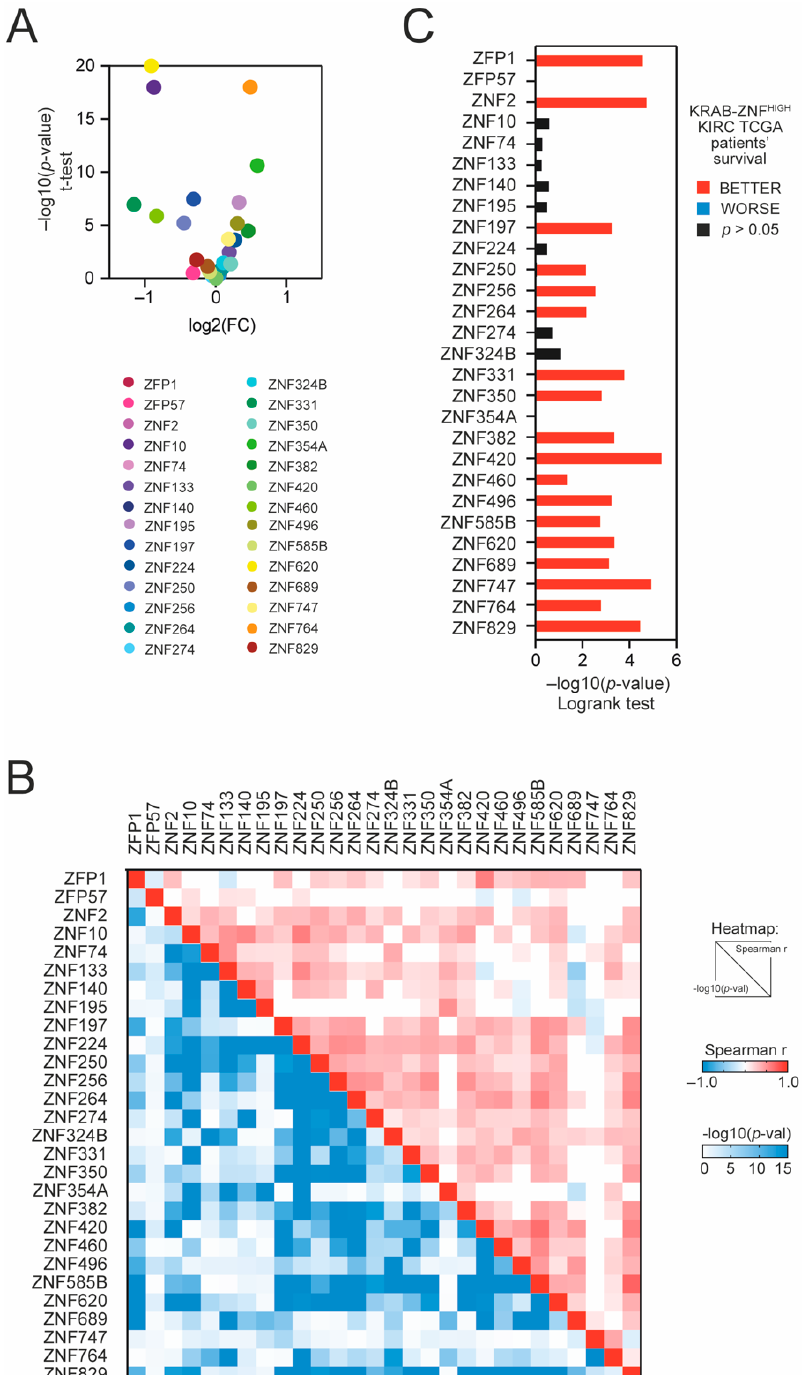
Figure 1. The expression of TRIM28-interacting KRAB-ZNFs in tumor and normal adjacent tissues and the association with kidney renal clear cell carcinoma (KIRC) patients’ survival. ( A ) The expression of TRIM28-interacting KRAB-ZNFs in tumor tissues and normal adjacent tissues based on TCGA data. ( B ) Correlation of KRAB-ZNF expression in KIRC tumor samples. The upper part of the heatmap presents the Spearman correlation coefficient, while the lower part of the heatmap shows the statistical significance of the correlation ( − log10-transformed). ( C ) The hazard ratio (log10(HR)) of death for patients with high expression of specific KRAB-ZNFs (with the mean as a cut-off). Red and blue denote lower and higher hazard ratios, respectively.